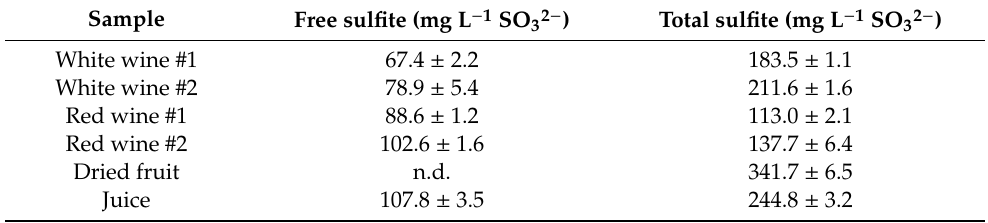
Table A3. Results of the determination of free and total sulfite in wine, dried fruit, and fruit juice samples obtained using the flow Systems I and II.